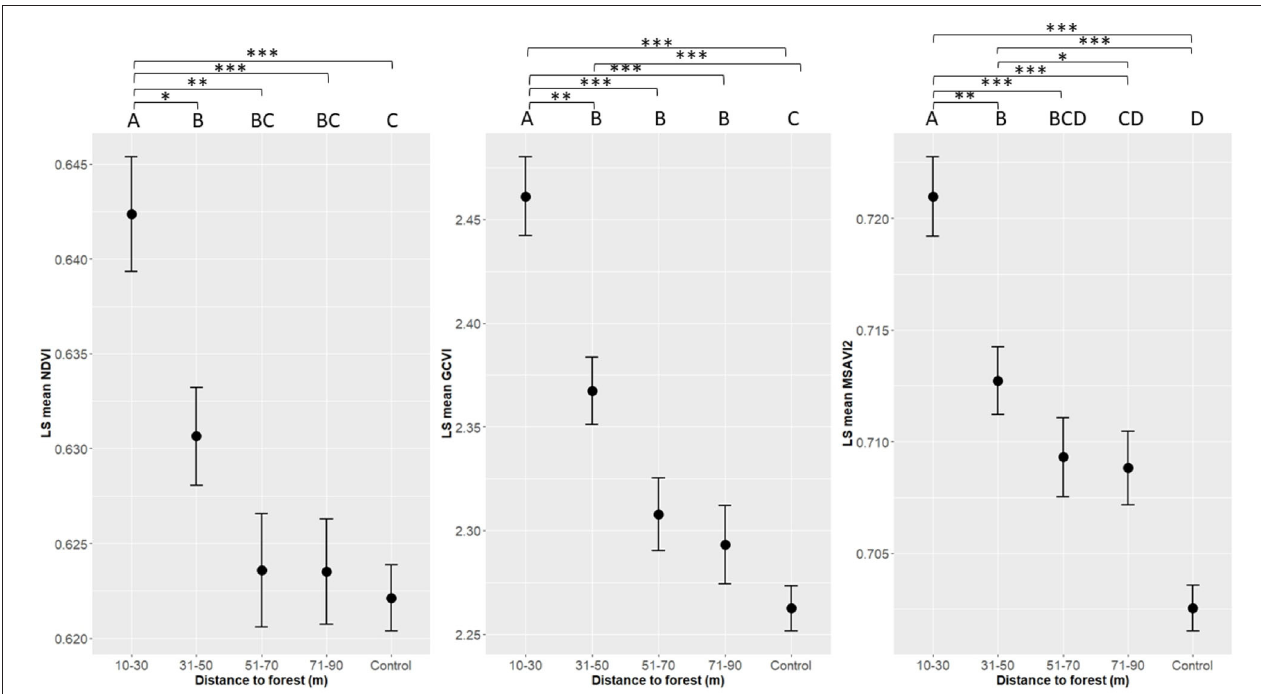
FIGURE 3 | Plot of least squares mean for NDVI, GCVI, and MSAVI in wheat fields at distances of 10–30, 31–40, 51–70, 71–90m, and control. Derived from linear model least squares means. Error bars denote standard error. n = 40 for all distance classes, n = 25 for control. * P ≤ 0.05, ** P ≤ 0.01, *** P ≤ 0.001.